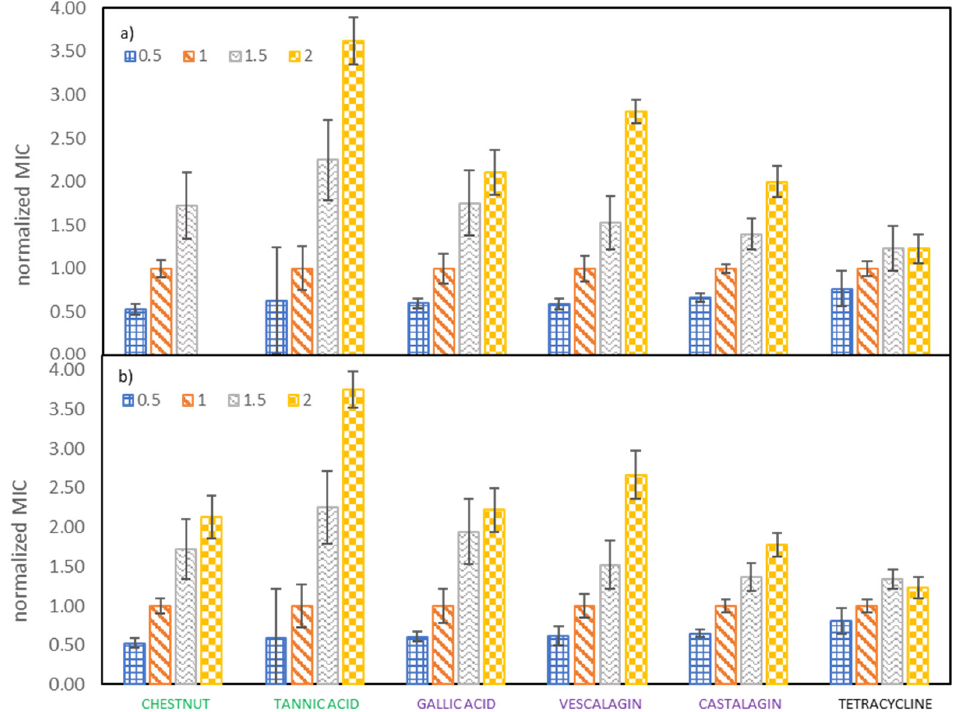
Figure 3. Dependence of the normalized MIC on the E. coli growth medium concentration, determined by ( a ) measuring OD and ( b ) using INT dye. MIC values were normalized with respect to the growth medium concentration recommended by the producer.